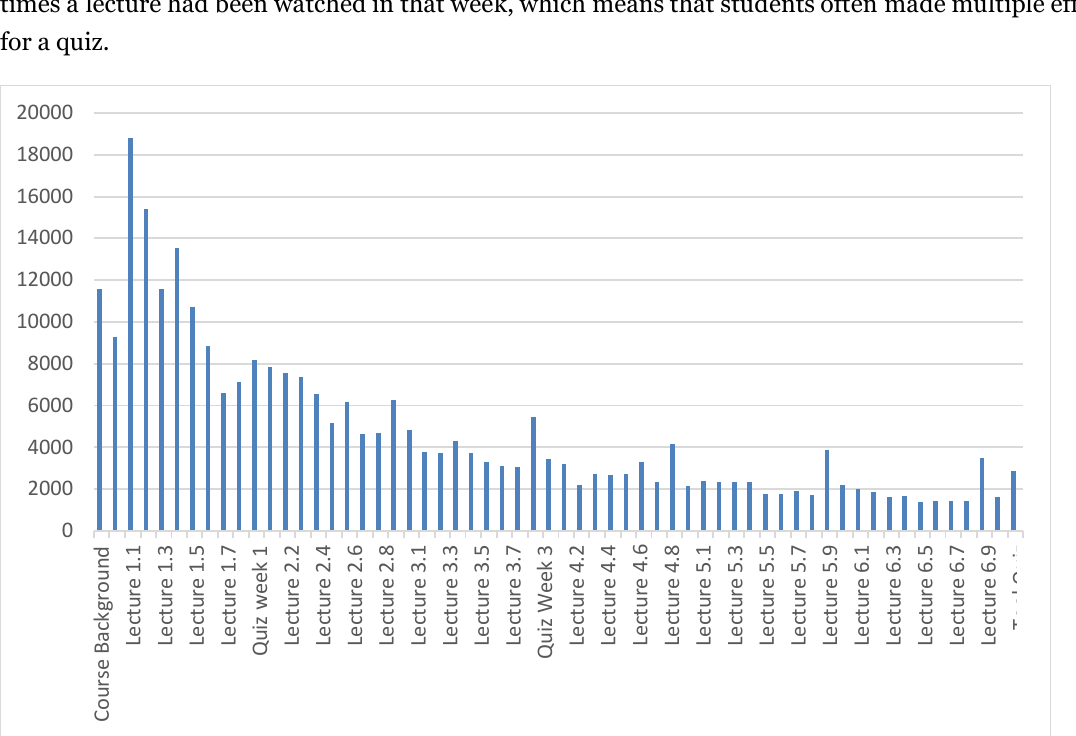
rhythm of activities. The arch shows the first activity of students, ordered along the timeline. The density of the dots indicates overall student